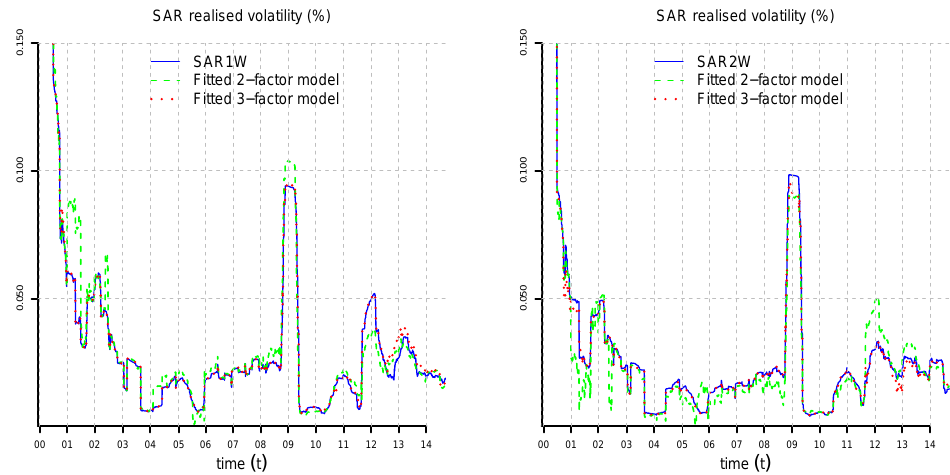
(cid:92) Figure 9. SAR realized volatility RCov ( t , τ , τ ) 1 2 for K = 126, τ = 5 (lhs), τ = 10 (rhs) and all observation dates compared to the realized volatility of the two- and three-factor Vasiˇcek models fitted by optimization (23) for M = 6, τ 1 = 1, τ 2 = 2, τ 3 = 5, τ 4 = 10, τ 5 = 21, τ 6 = 63 and w ij = 1 { i = j } .